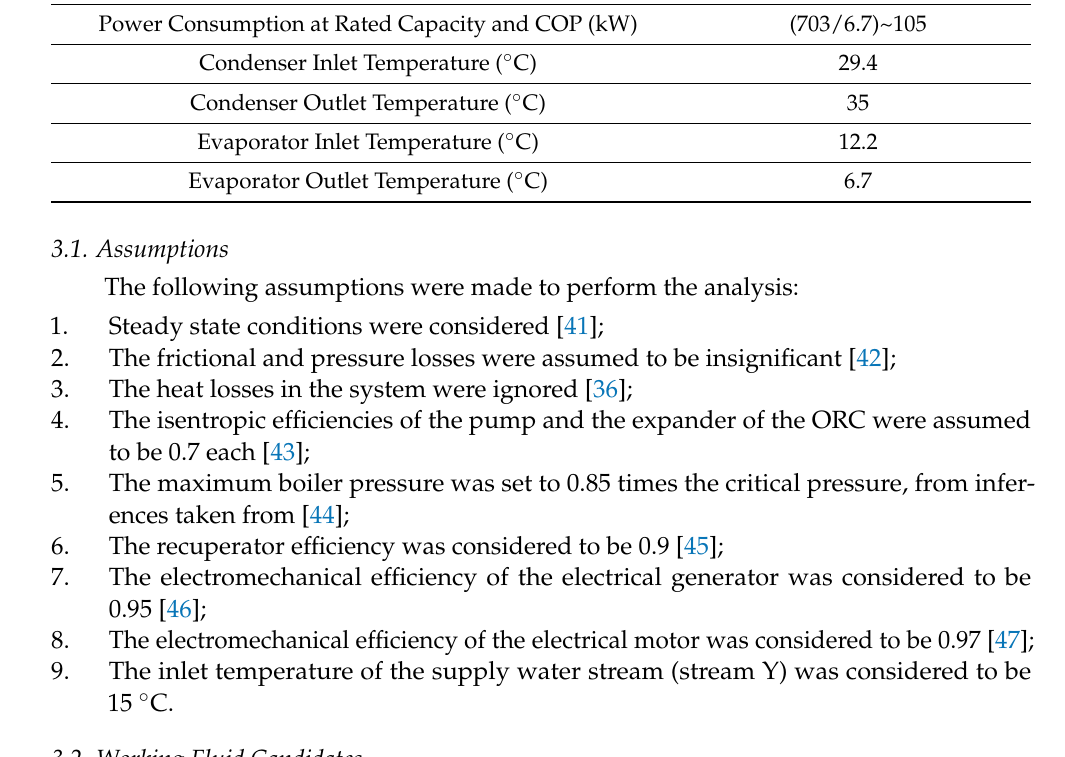
Table 2. Specifications of the VCC adopted for this study [40].